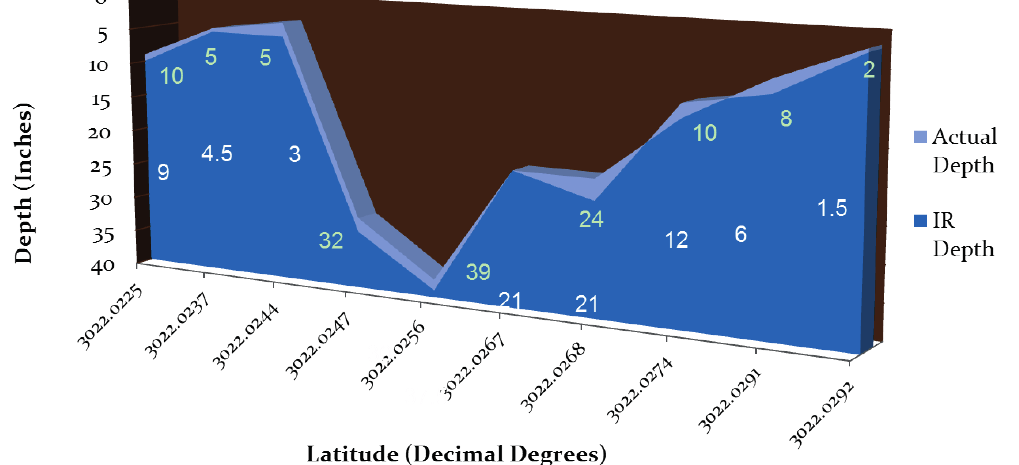
Fig. 4 Sub-bottom profile comparison between actual depth and depth measured with designed depth measuring